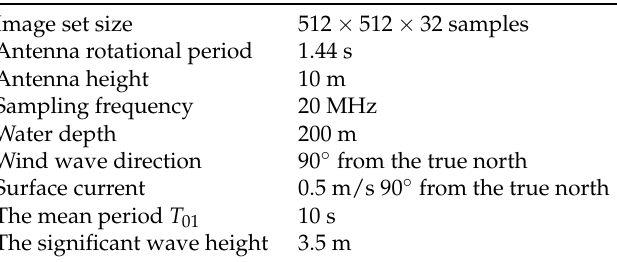
Figure 2. Simulation analysis for shadowing and tilting ( a–f ): ( a ) Directional wave spectrum used to generate simulated radar images; ( b ) Simulated surface elevation; ( c ) Shadowing mask; ( d ) Tilting mask; ( e ) Shadowing percentage dependency on the azimuthal direction; ( f ) Tilting factor dependency on the azimuthal direction. Table 1. Experiment setup: Simulation